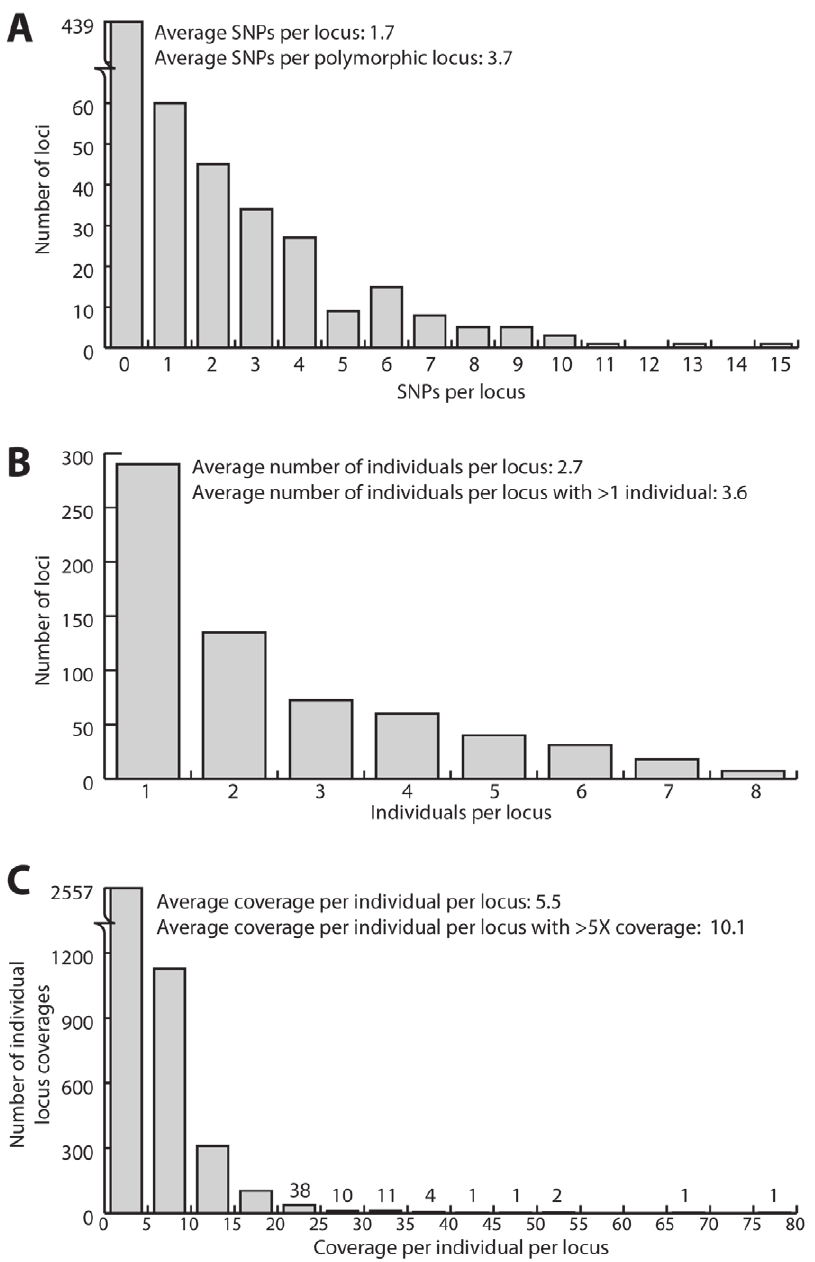
Figure 4. Summary histograms of important parameters in the rail dataset. Number of polymorphic sites ( A ), individuals present in each locus ( B ), individual coverage on a per locus basis ( C ). Note the scale of the dependent axis changes on ( A ) and ( C ).